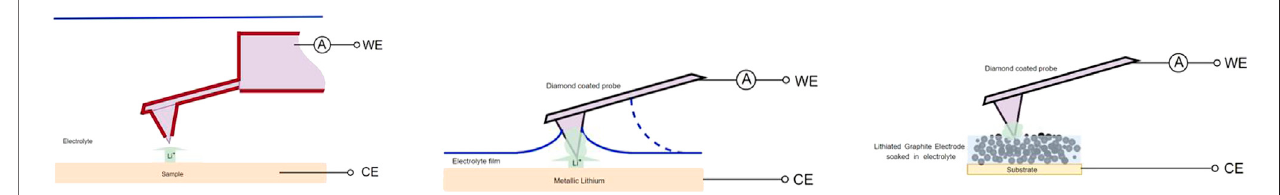
FIGURE4 | Wet probe lithiation methods. Left: Immersing method; Middle: thin fi lmmethod; Right: soaked electrodemethod (reference electrode wasconnected to CE in all situations).